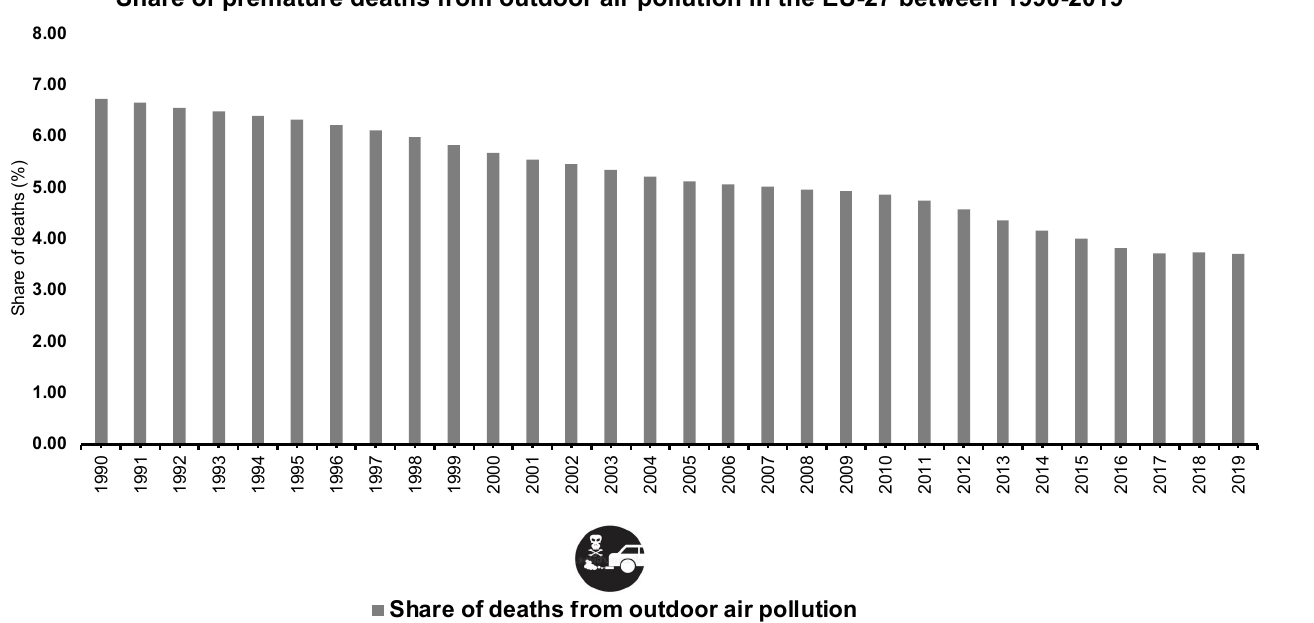
Figure 1. Share of premature deaths from outdoor air pollution in the EU-27, between 1990–2019. This figure was created by the authors with data from Our World in Data [3].